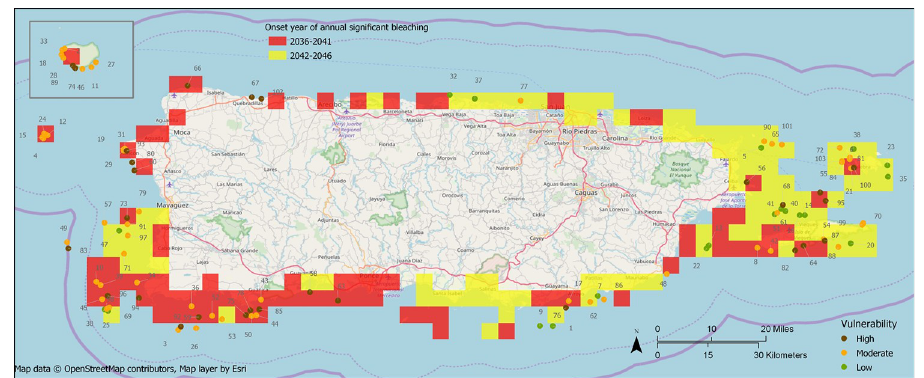
Fig 7. Reef survey sites (n = 103) with resilience rank (without temperature variation indicator), year of onset for annual significant bleaching (ASB) under RCP8.5 scenario, and site vulnerability category. Isla de Mona is the inset in the top left. ASB onset estimates are from van Hooidonk et al. (2016). Low exposure sites have ASB onset in 2042 or later while high exposure sites have ASB onset in 2041 or earlier. Vulnerability matrix: combination of exposure (year of onset of ASB) and resilience to produce relative vulnerability categories: high, moderate, and low. High resilience sites are sites in the two most resilient quartiles while low resilience sites are in the two least resilient